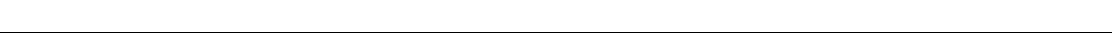
Fig. 2 Association analyses reveal Cacna2d1 as a candidate for IOP modulation. a IOP levels vary among the BXD strains. IOP of BXD strains carrying wild-type alleles of Tyrp1 and Gpnmb (WT/WT; blue bars), wild-type Tyrp1 and mutant Gpnmb (WT/MUT; green bars), mutant Tyrp1 and WT Gpnmb (MUT/WT; yellow bars), and mutant alleles of both genes (MUT/MUT; red bars) are shown. n = 65 strains, age = 9.1 – 13 months. Values denote IOP levels on mmHg scale (mean ± SEM). b No differences in IOP between sexes. There is a strong statistical association between the IOP of males and females ( P < 0.0001). The relationship between the sexes is positively correlated ( R 2 = 0.37, Pearson correlation coef fi cient = 0.62). c Genetic interval mapping revealed a single signi fi cant eQTL on proximal Chr 5. This is distinct from the locations of Tyrp1 and Gpnmb in the genome (black vertical lines on Chr 4 and Chr 6, respectively). d Tyrp1 and Gpnmb haplotypes do not in fl uence IOP in BXD mice. The scatter plot shows average IOP of BXD strains carrying wild-type alleles of Tyrp1 and Gpnmb (WT/WT), wild-type allele of Tyrp1 and mutant allele of Gpnmb (MUT/WT), mutant allele of Tyrp1 and wild- type allele of Gpnmb (WT/MUT), and mutant alleles of both genes (MUT/MUT) ( n = 65, P = 0.13, age = 9.1 – 13 months). P -value was calculated using an ANOVA. e Stringent selection criteria for selecting candidate genes. f A signi fi cant QTL for IOP is present on chromosome 5 between 14 – 19 Mb. Cacna2d1 is the strongest candidate gene located in the peak QTL. g Gene set enrichment analysis for positive correlates of Cacna2d1 . Gene correlates of Cacna2d1 were signi fi cantly enriched for localization to the plasma membrane. False discovery rate (FDR) cutoff was set as q ≤ 0.25. h Gene set enrichment analysis of genes positively correlated with Cacna2d1 presented as molecular function groupings. Categories that are statistically over-represented are shown with their normalized enrichment score (NES) listed next to the